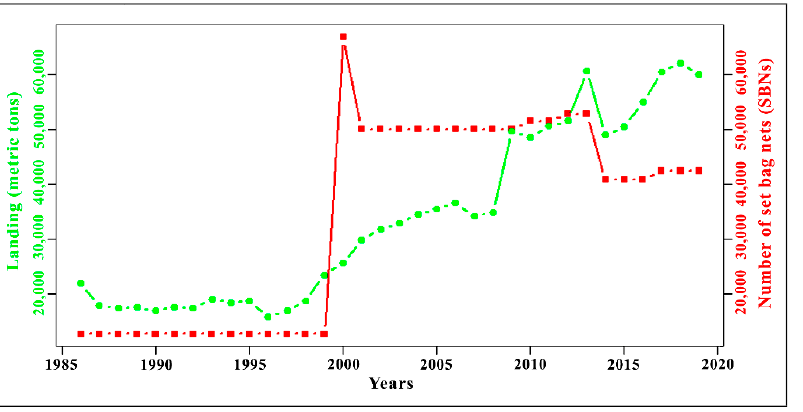
Figure 3. Trends in annual landing and number of set bag nets for Bombay duck in marine water of Bangladesh from 1986 to 2019. Here, green dots indicate the landing in metric tons, and red dots indicate the number of set bag nets.